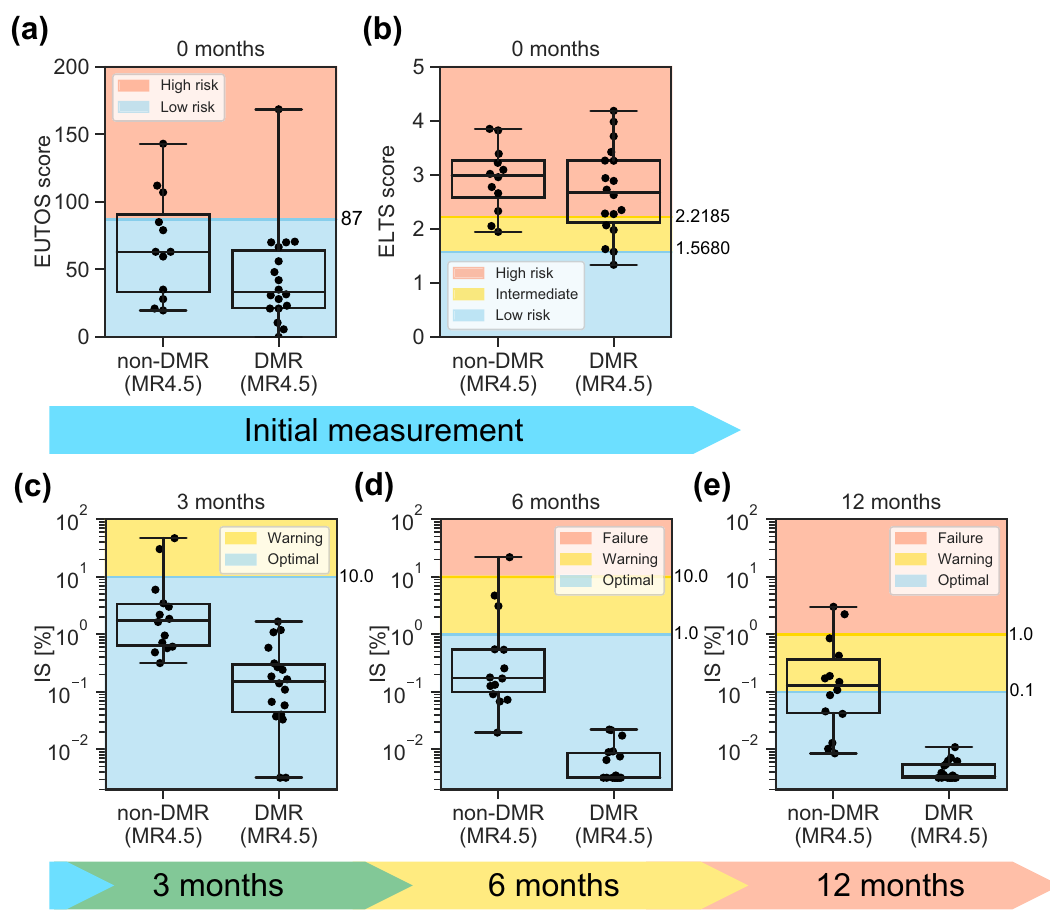
Fig. 1 Several criteria of the current scoring systems and guidelines are not suitable for DMR classi fi cation. Each dot indicates each patient value within the N-road dataset. The top and bottom bars of the boxes indicate the maximum and minimum values, respectively. The top, center, and bottom lines are the upper quartiles, medians, and lower quartiles, respectively. Patients are divided into two groups: a DMR patient set and a non-DMR patient set. a The EUTOS score did not predict non-DMR patients. The patient is considered “ High risk ” if the EUTOS score of a CML patient is >87 and “ Low risk ” otherwise. b The ELTS score did not also predict non-DMR patients. A CML patient is considered as “ High risk ” if the patient ’ s ELTS score is >2.2185, “ Low risk ” if the score is 1.5680 or lower, and “ Intermediate risk ” otherwise. c – e According to the ELN guideline, we plotted patient IS and separated them into three groups: “ Optimal ” , “ Warning ” , and “ Failure ” for the data at ( c ) 3, ( d ) 6, and ( e ) 12 months after the initiation of TKI administration. In c , d many non-DMR patients were predicted as “ Optimal ” , indicating the failure of these